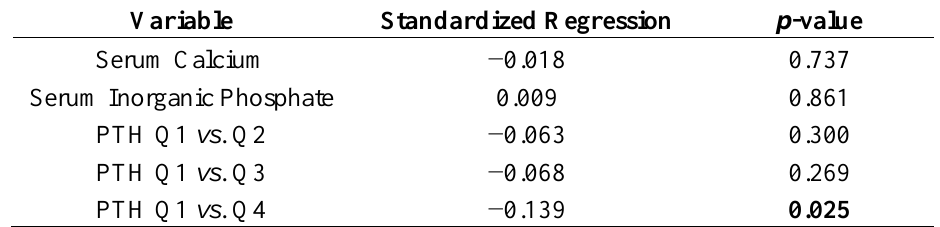
Table 5. The association between the serum 25(OH)D level and biochemical factors. PTH, parathyroid; IPAQ, International Physical Activity Questionnaire.